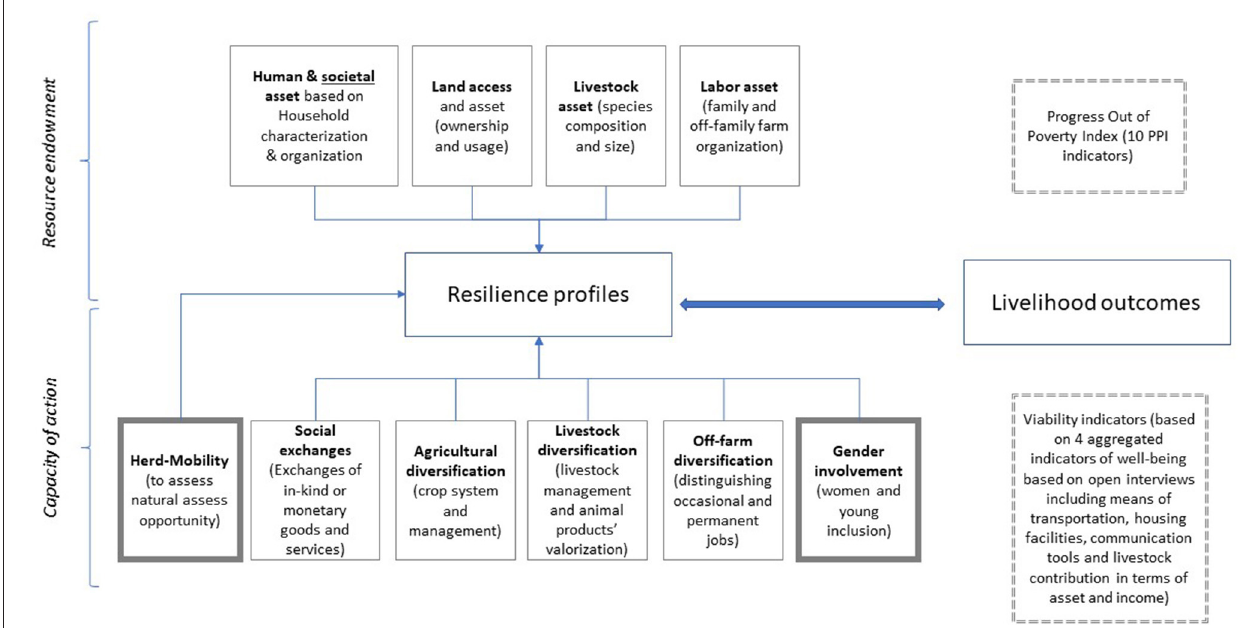
FIGURE 2 | Framework for analyzing the resilience